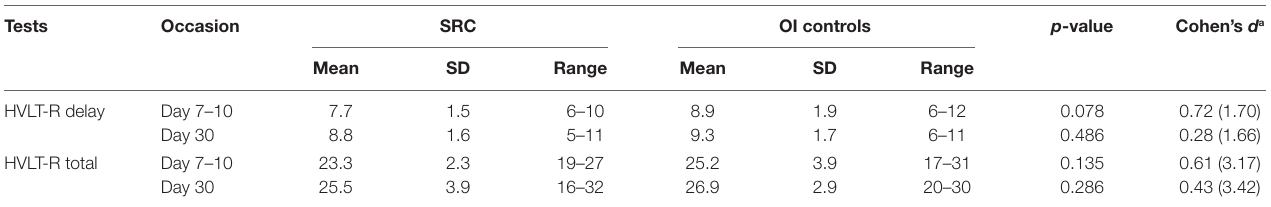
Table 2 | Mean verbal learning and memory scores for the src and Oi control